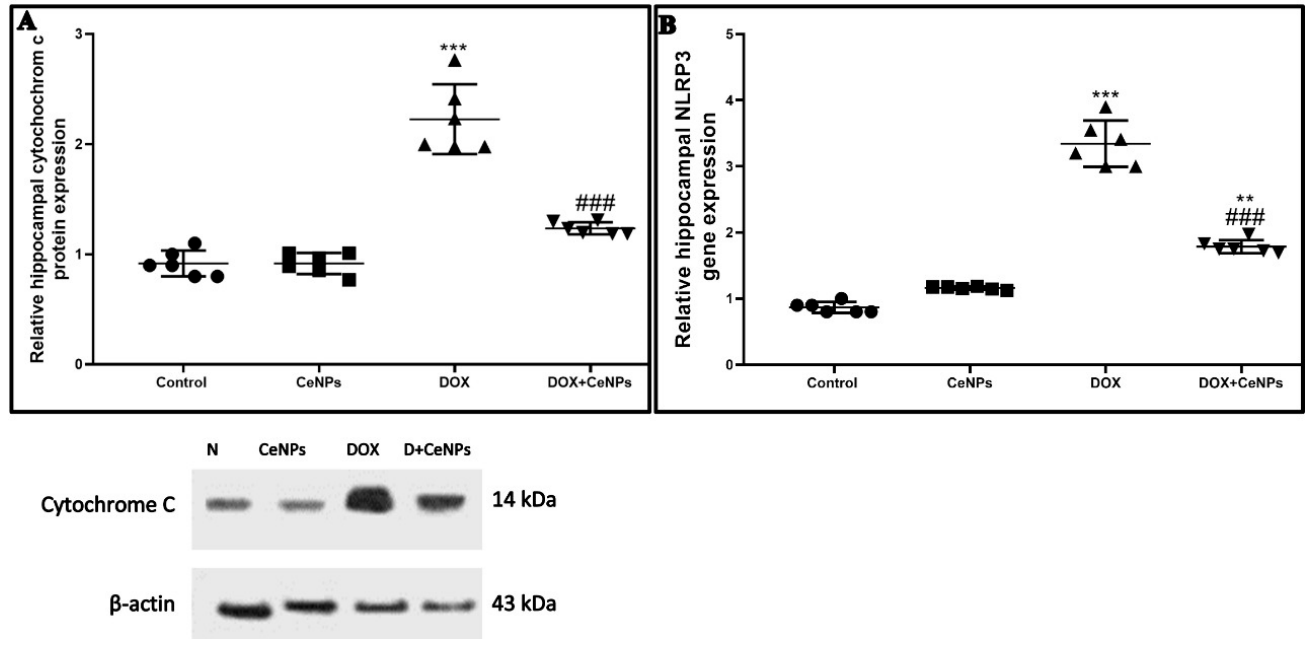
Figure 8. Effect of nanoceria treatment on the expression of cytochrome c protein and relative gene expression of NLRP3 in various groups of rats. ( A ) Cytochrome c protein expression as evaluated by Western bloating assay. ( B ) Relative gene expression of NLRP3. All data are elucidated as mean ± SD. One-way ANOVA test followed by Tukey’s post hoc test was used, *** p < 0.001 and ** p < 0.01 vs. control group, ### p < 0.001 vs. DOX group.